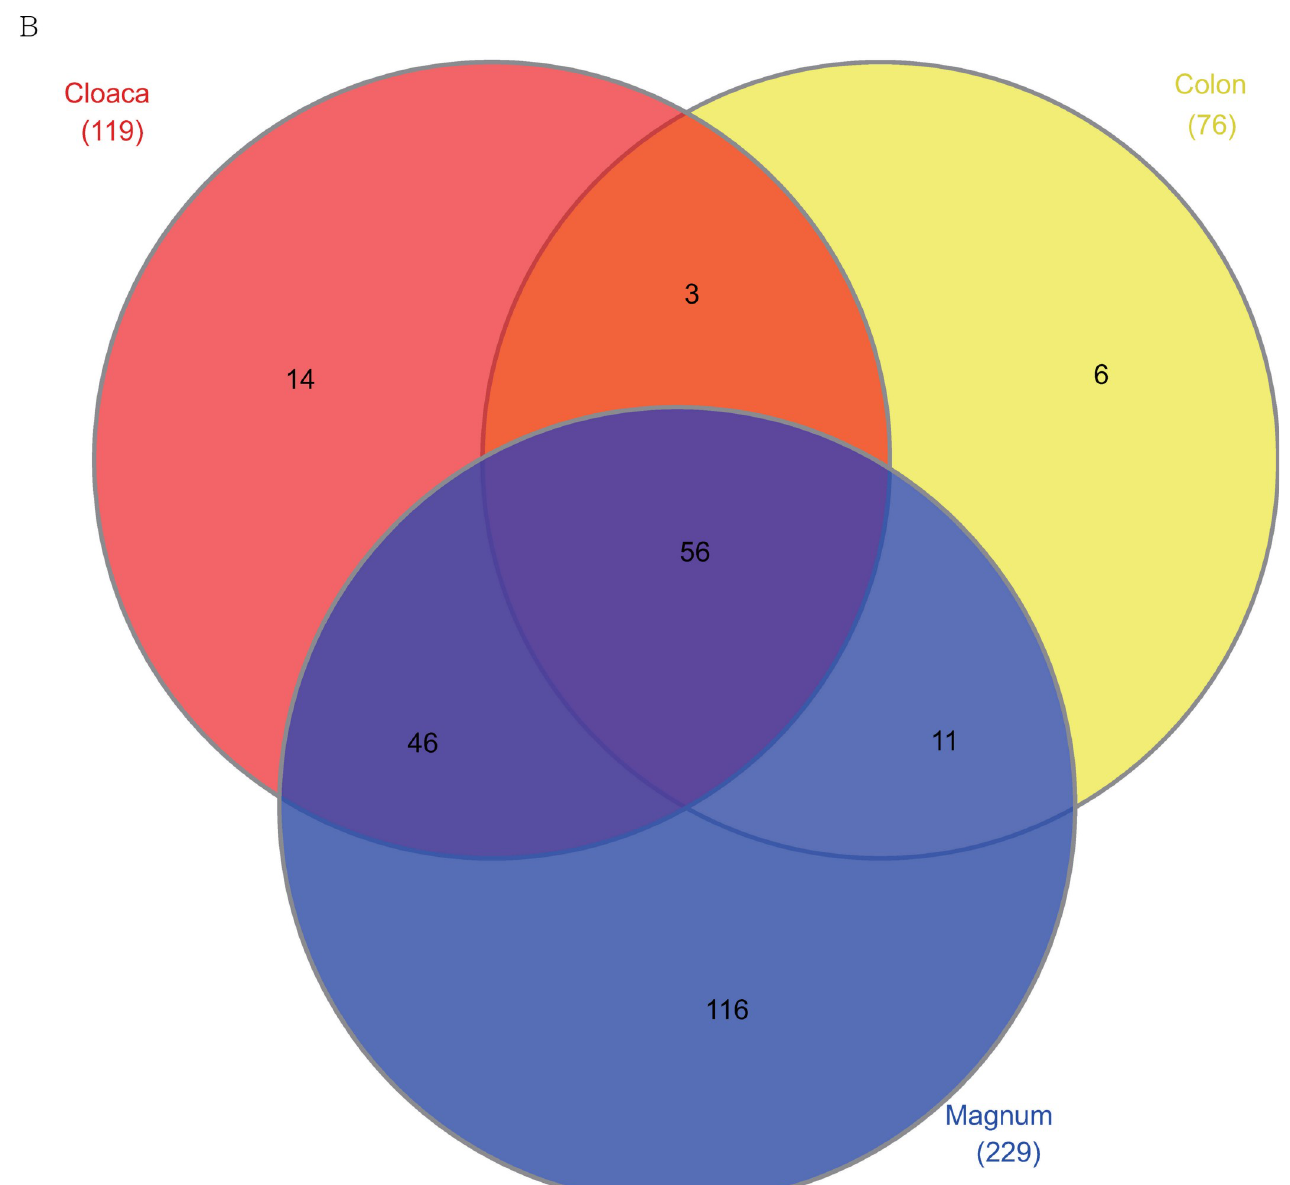
Fig 6. Common and unique phylotypes at the genus level among each group. Venn diagram demonstrating the number of common or unique phylotypes at the genus level among the groups. Phylotypes observed in each part were counted.